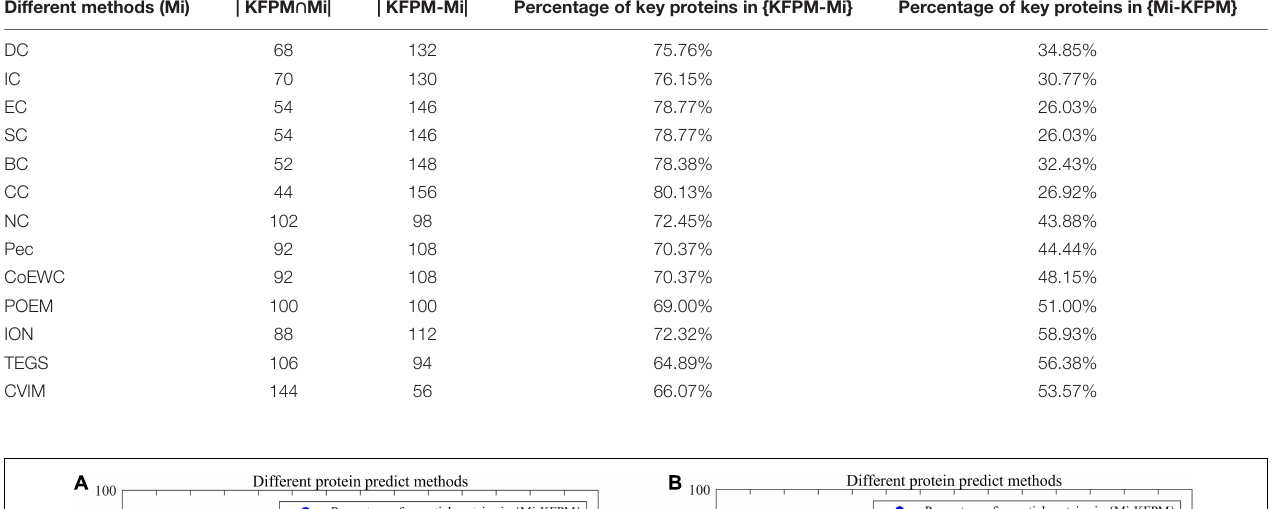
TABLE 3 | Commonalities and differences between KFPM and 13 competitive methods based on top 200 ranked proteins under the Krogan database. Different methods (Mi)